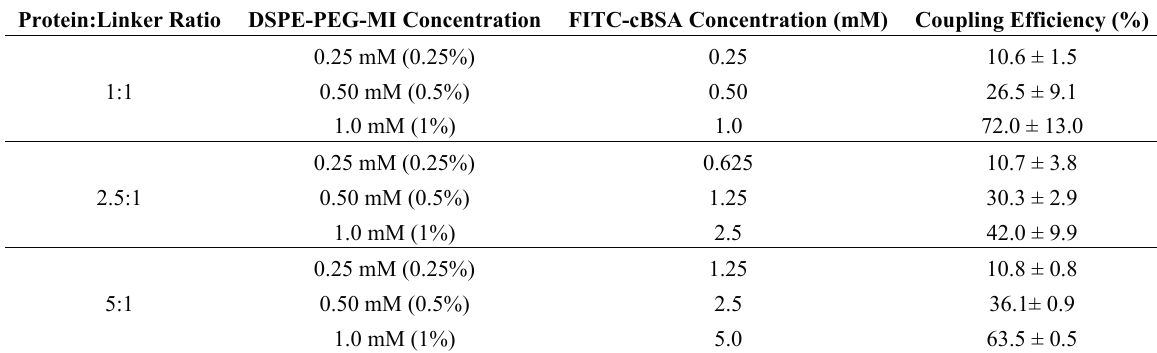
Table 1. Coupling efficiency in respect to protein:linker ratio and linker concentration. Efficiency values are mean ± standard deviation ( n =